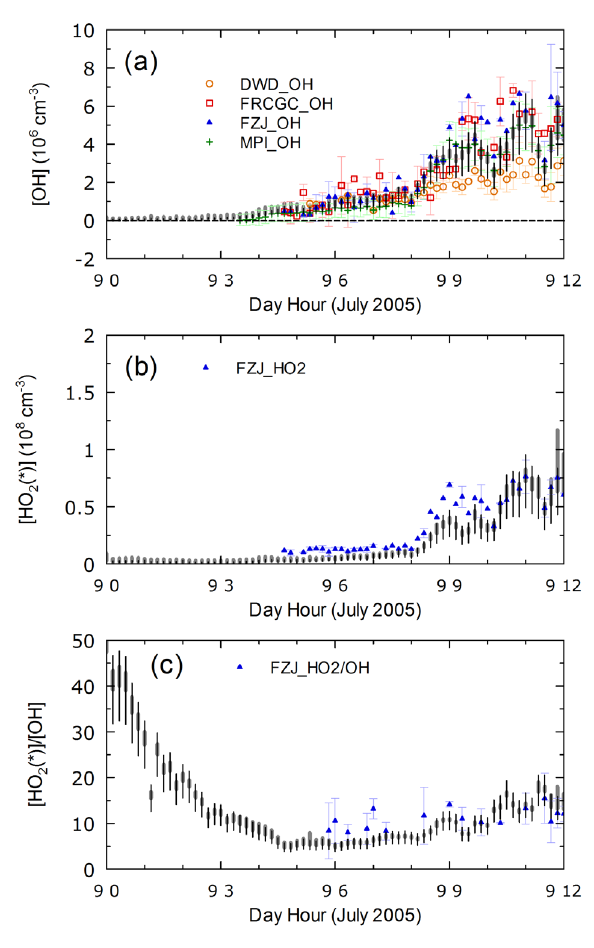
Fig. 8. Comparisons of observed and modeled (a) OH and (b) HO 2 (*) concentrations, and (c) HO 2 (*)/OH ratios with the full Figure 8. Comparisons of observed and modeled (a) OH and (b) HO range of model ensemble results (gray bars) and uncertainty range (1 σ ) of the Base run (black bars) on the morning of 9 July. The col- ored error bars represent 1 σ ranges of observations during 10min (*)/OH ratios with the full range of model ensemble results (gray bars) and uncertainty range (1 σ ) HO 2 and do not represent systematic uncertainties of the of the Base run (black bars) on the morning of 9 July. The colored error bars represent 1 σ ranges of